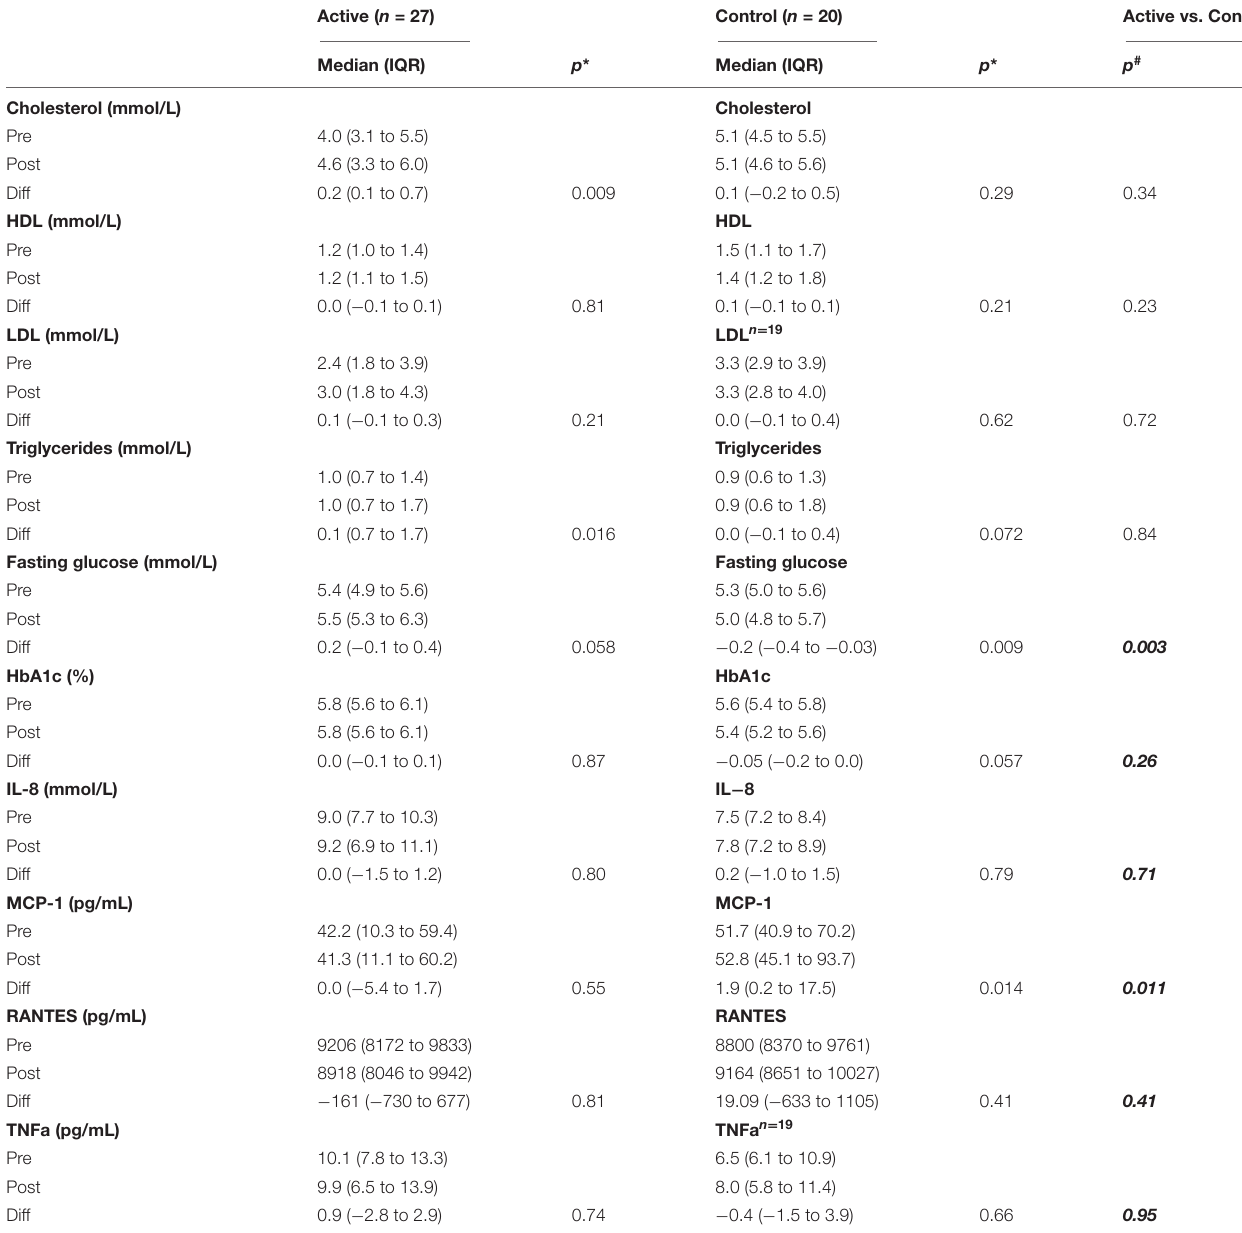
TABLE 2 | Changes from baseline to 16 weeks follow-up in serum variables, for participants with supplementation (active) and for control participants. Active ( n = 27) Control ( n = 20) Active vs.